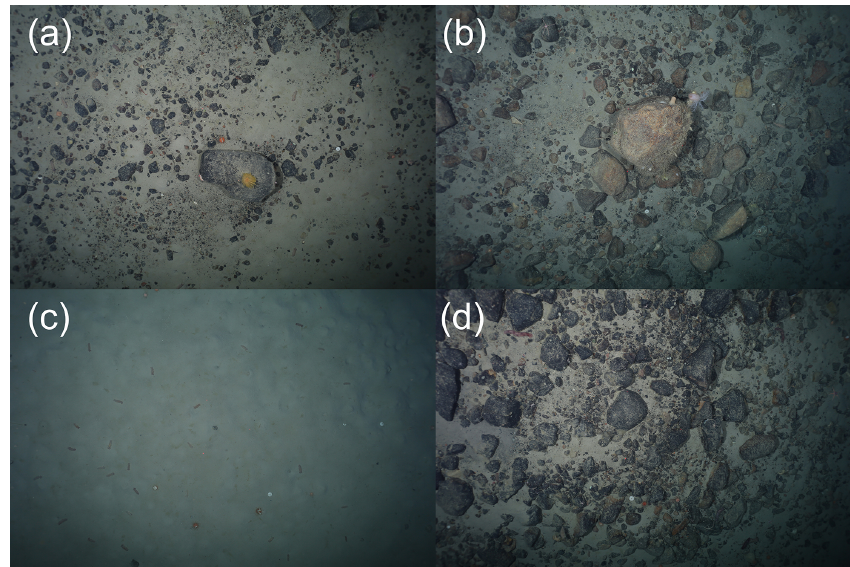
Figure 9. Typical seafloor images collected from each of the OFOBS surveys made of the southern Filchner Trough seafloor dur- ing RV Polarstern cruise 124. All images were taken during deployment Station PS124_94-5. (a) SW_RELEASER_2021_03_07 at 23_03_46 IMG_0115.JPG, (b) SW_RELEASER_2021_03_08 at 00_31_37-JPG, (c) TIMER_2021_03_07 at 23_29_54 IMG_0207.JPG, (d) TIMER_2021_03_07 at 23_30_14 IMG_0209-JPG. The three red points within each image represent the sizing lasers (50cm spacing). All images are presented here and in the dataset with no manipulation or colour correction.